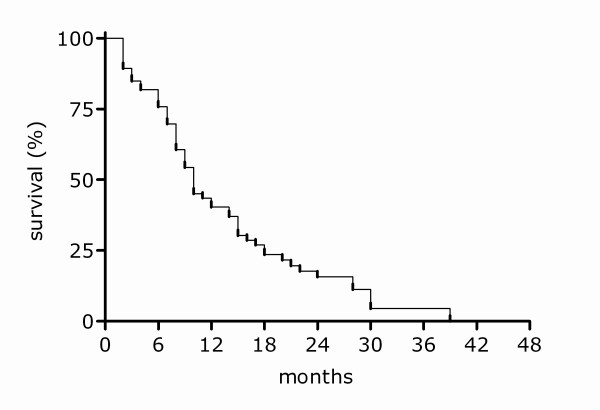
Survival curve of 81 CUP patients analyzed